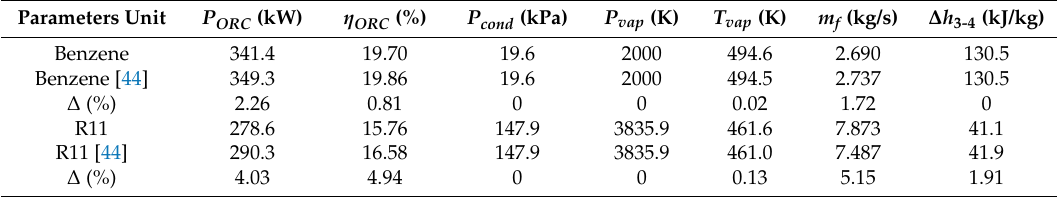
Table 5. Comparison of ORC results between the present computation and reference [44].